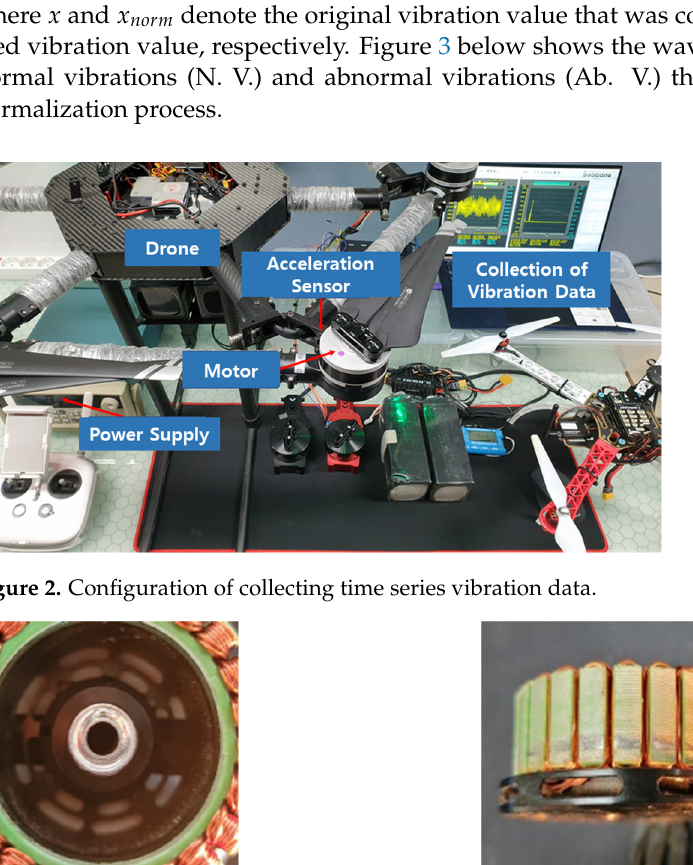
Figure 2. Configuration of collecting time series vibration data.